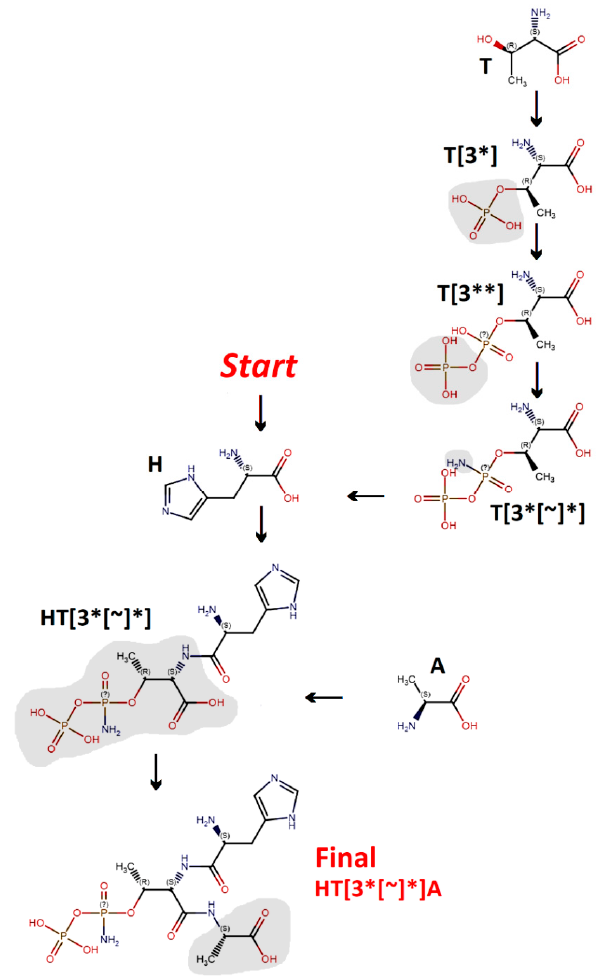
Figure 4. Structures of compounds corresponding to the SMILES strings presented in Figure 3. Fragments added in given steps are shaded. Configuration around asymmetric carbon atoms (R or S) is indicated. Character “?” indicates asymmetric phosphorus atoms without defined configuration. Figure prepared using Marvin Sketch editor.